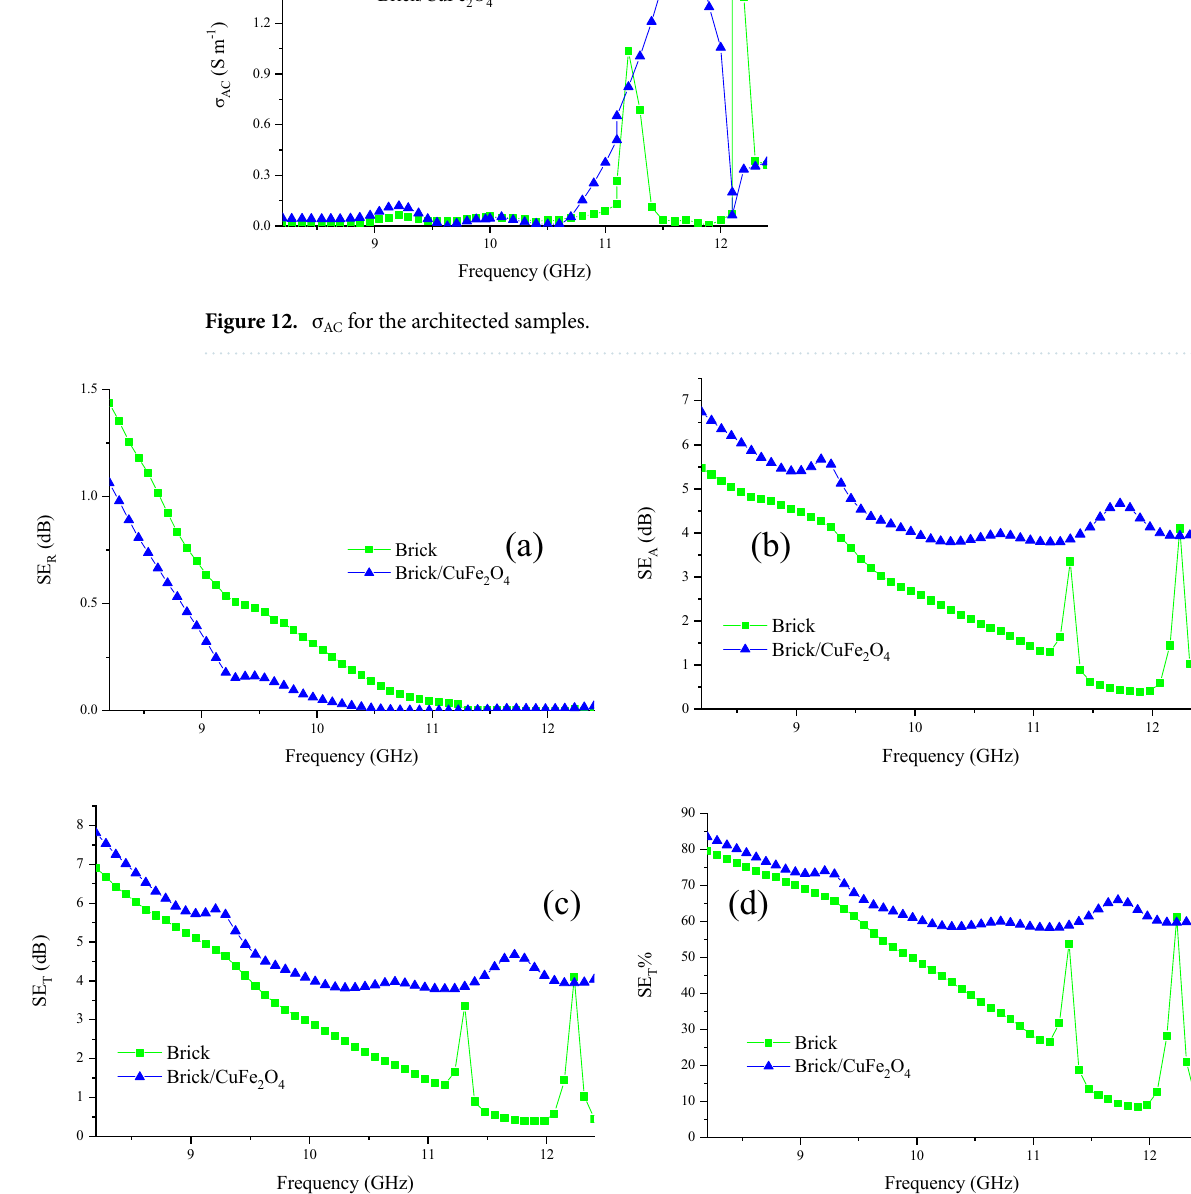
Figure 13. SE R ( a ), SE A ( b ), SE T ( c ), and SE T% ( d ) of the brick and brick/CuFe 2 O 4 nanocomposite from 8.2 to 12.4